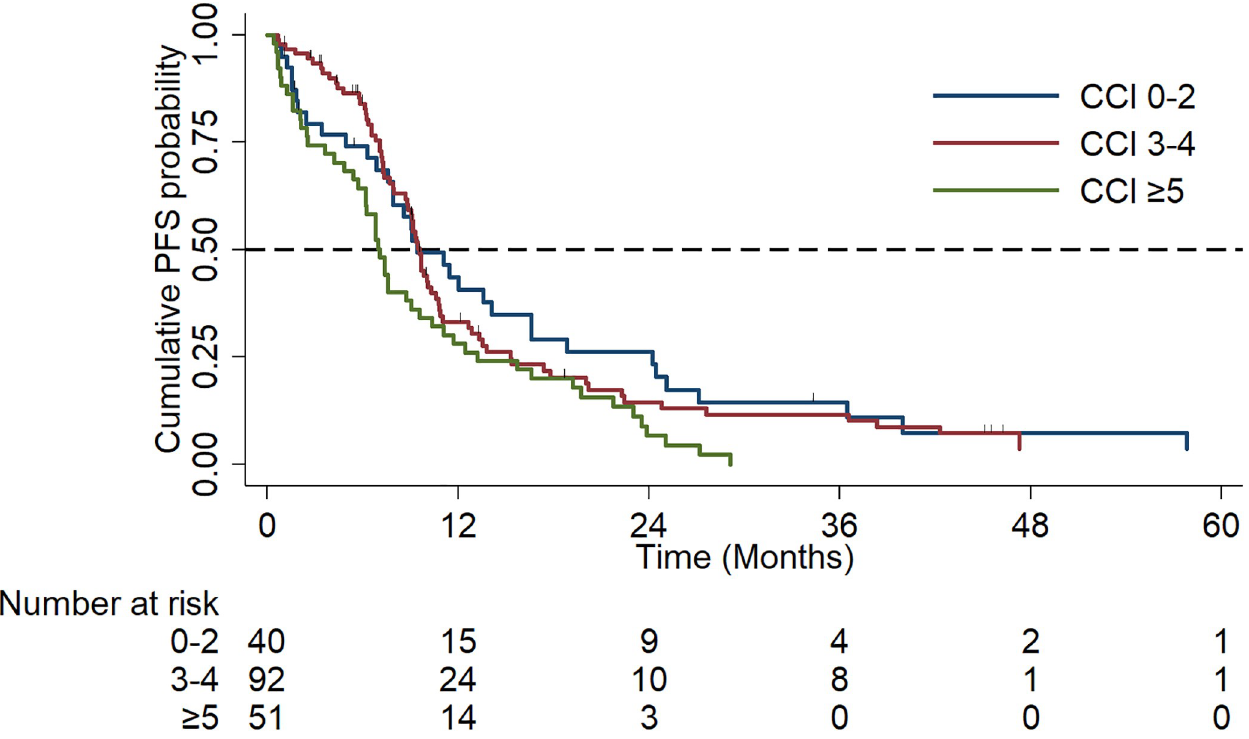
Fig 7. Kaplan Meier Curves of progression-free survival (PFS) by Co-morbidity Index (mild (0–2) vs. moderate (3–4) vs. severe ( � 5)).